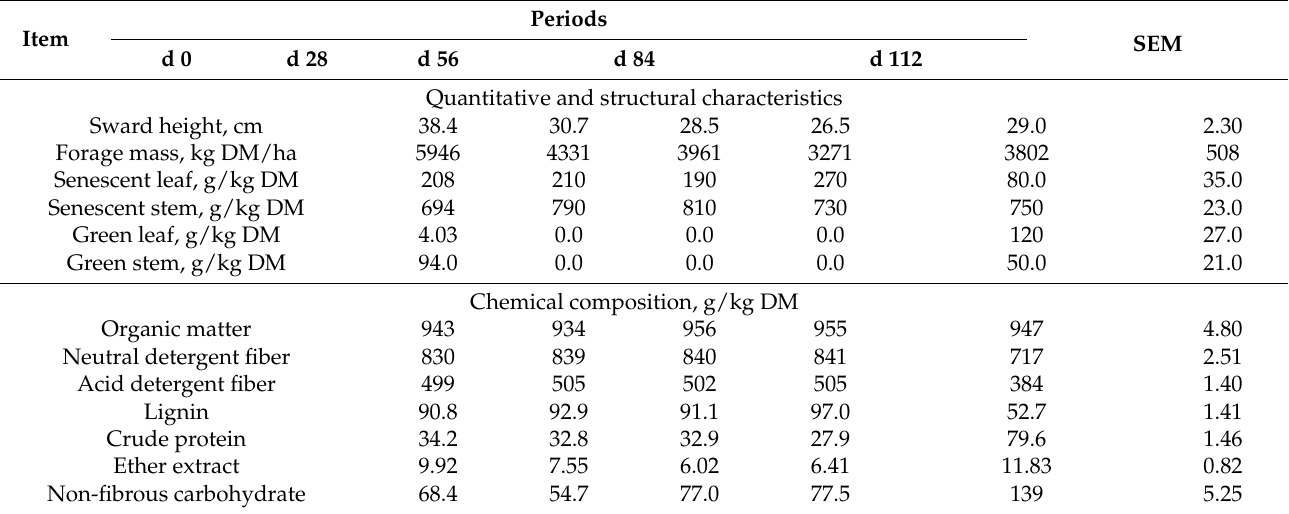
Table 2. Characteristics of the forage sward, grazed by Nellore bulls finished on pasture with high concentrate supplementation, with monensin (MON) or a blend of live yeast and organic minerals